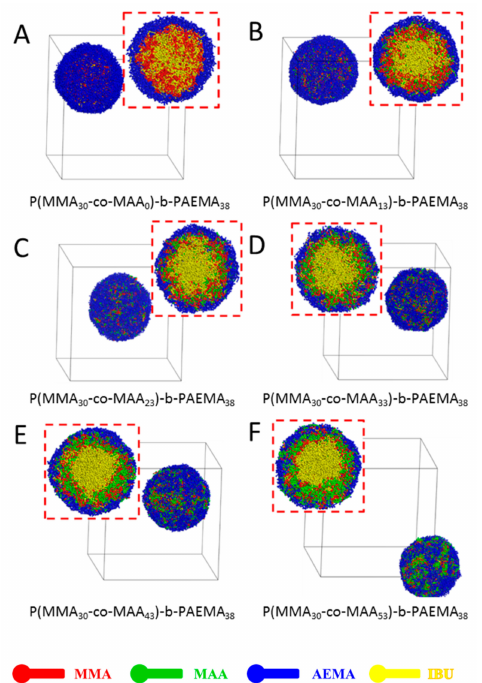
Figure 3. Full-section and cross-section views of IBU-loaded PMs at di ff erent ratios of MAA blocks at 400,000 steps during DPD simulation (poly(MMA 30 - co -MAA y )- b -PAEMA 38 , ( A ) y = 0, ( B ) y = 13, ( C ) y = 23, ( D ) y = 33, ( E ) y = 43, ( F ) y =